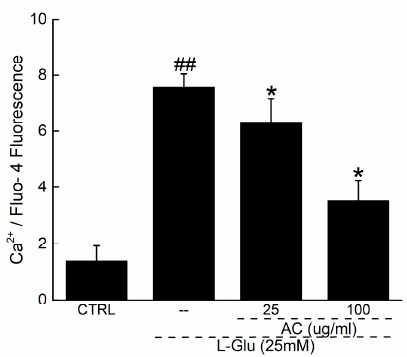
Figure A1. Effect of AC on the over-load of intracellular Ca 2+ caused by 12-h L -Glu. Quantitative analysis of Ca 2+ values of fluorescence intensity obtained from Figure 2C ( n = 6). ## p < 0.01 vs. CTRL, * p < 0.05 vs. L -Glu-treated cells.